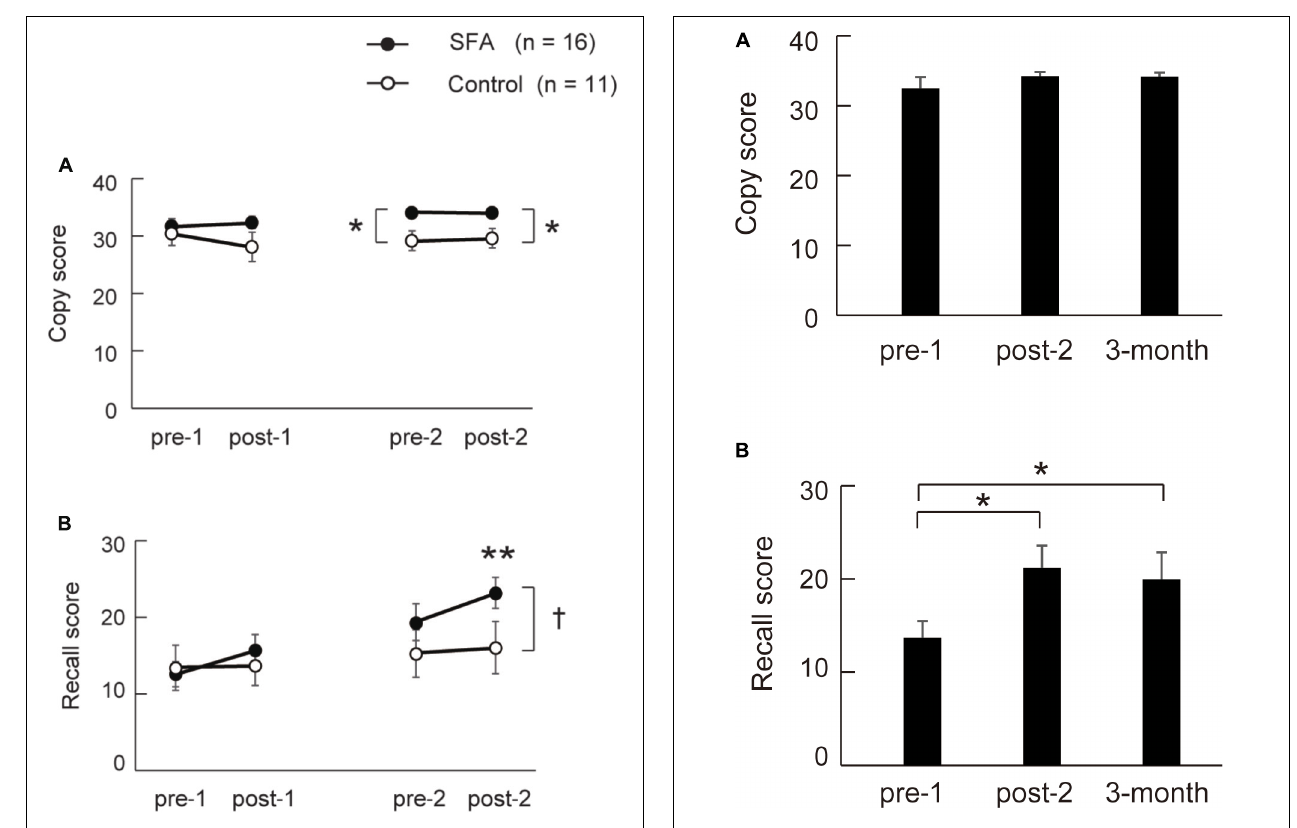
FIGURE 3 | Mean scores of Rey–Osterrieth complex figure copy (A) and recall (B) test in SAF-treated and non-treated (Control) groups. ∗ p < 0.05, ∗∗ p < 0.01, † p < 0.10.